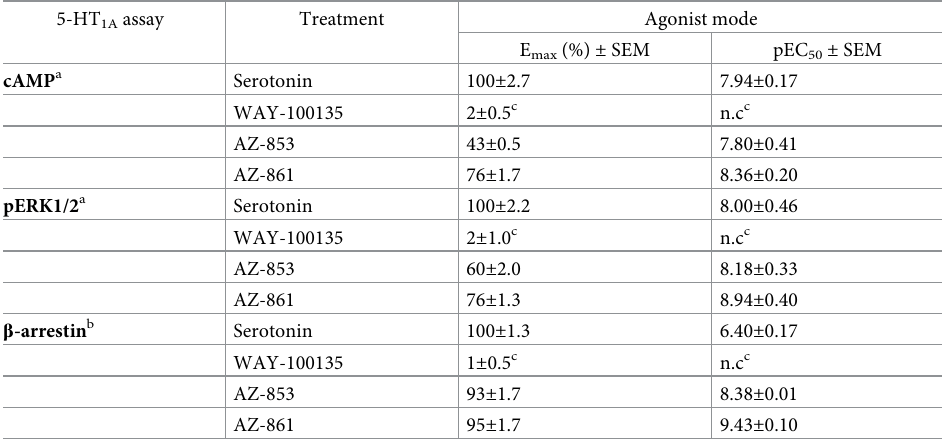
Table 1. Intrinsic activity of AZ-853 and AZ-861 at 5-HT 1A R in vitro functional assays.